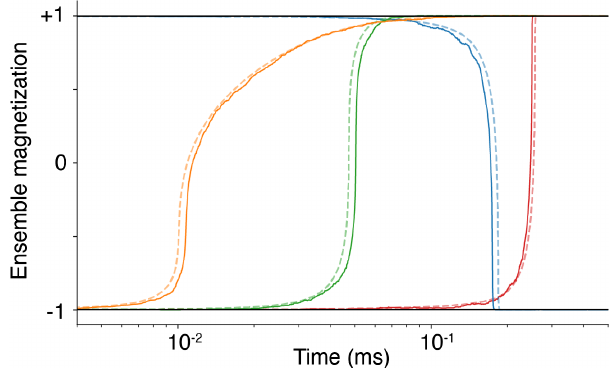
FIG. 17. Comparison between the mean-field equations of motion (dashed lines) in Eq. (F3) and a full stochastic unraveling of the cavity master equation (solid lines) for a system with N ¼ 100 spin ensembles each with M ¼ 10 3 atoms. Four ensembles are initially misaligned from a local minimum spin configuration of the Hopfield energy landscape and are corrected by the cavity